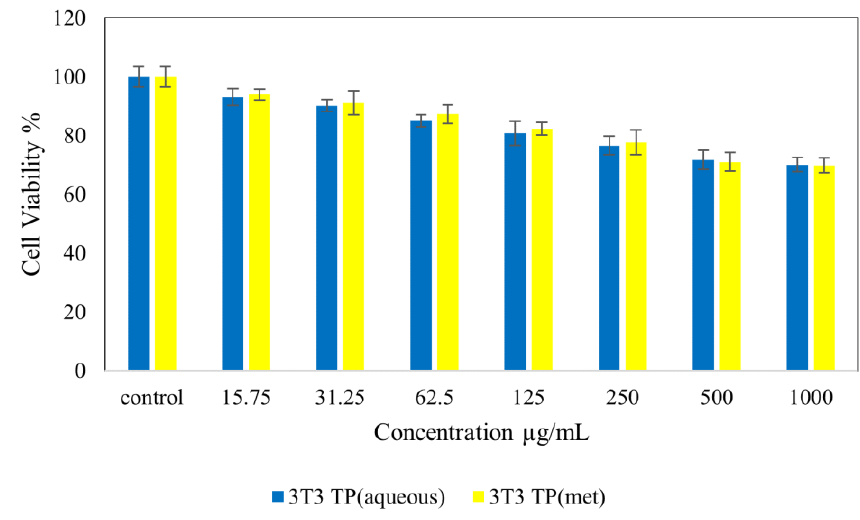
Figure 4. Cytotoxic activity of extracts against normal 3T3 cells at 48 h.